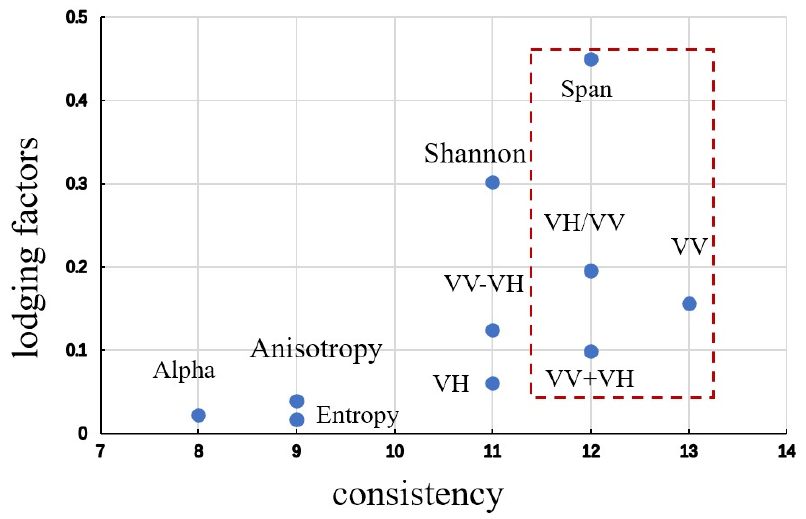
Figure 6. Scatter graph representing the lodging factor ( γ ) and consistency detection criterion ( β ) of the ten SAR characteristic parameters. The optimal four parameters that meet the conditions are highlighted with red